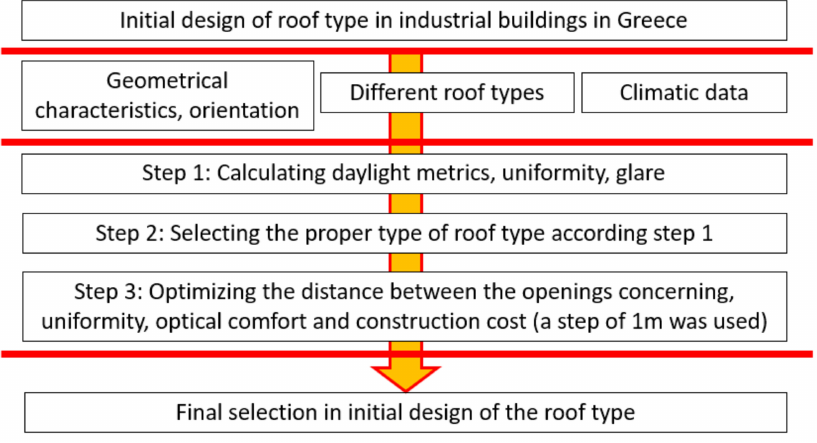
Figure 3. Diagram of the methodology.